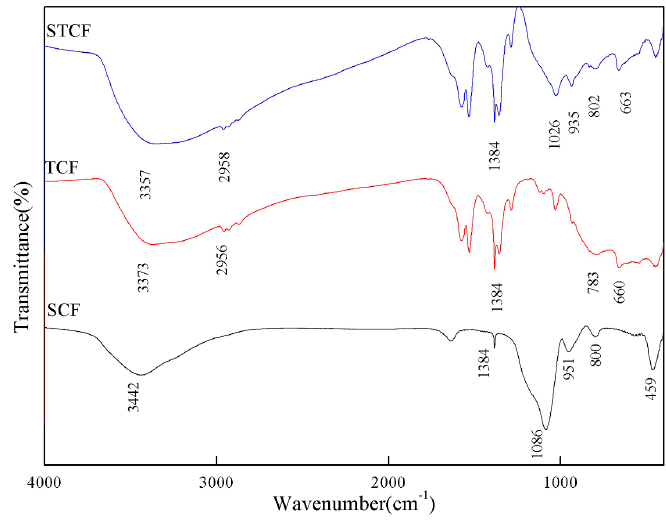
Table 1. Wavenumbers of absorption peak for main groups